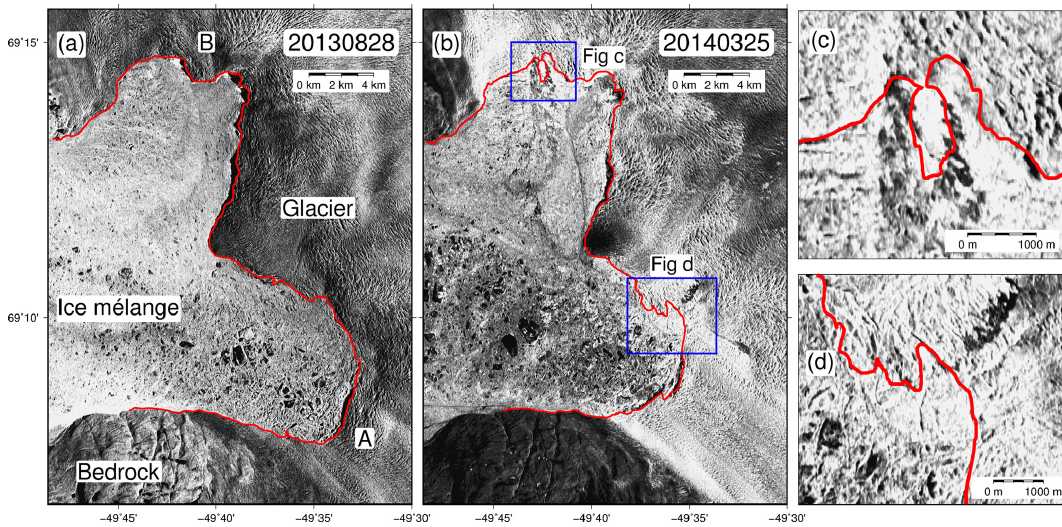
Figure 4. Examples of (a) superior and (b) inferior delineation from our deep-learning-based method. In both (a) and (b) , the red line shows the calving front delineated by the network. (c) and (d) show the zoomed-in figure of the obscure calving front positions within the blue boxes in (b)